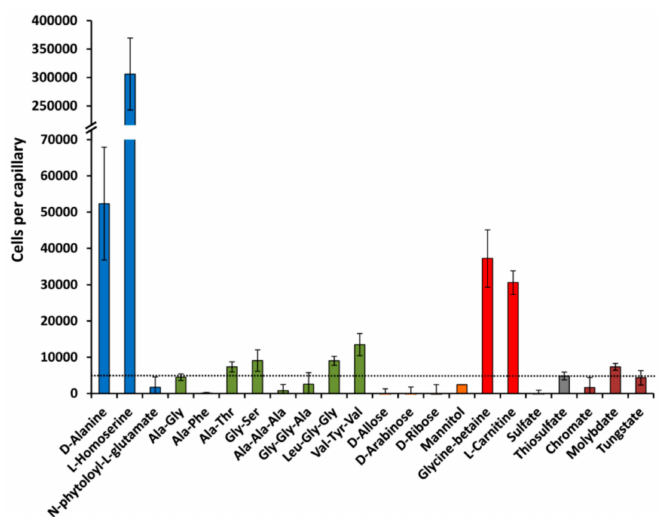
Figure 10. Chemotaxis of Pseudomonas aeruginosa PAO1 towards di ff erent ligands recognized by solute binding proteins. In all cases, the chemoe ff ector concentration was 1 mM, except molybdate which was at 0.1 mM. Data are means and standard deviations from three biological replicates conducted in triplicate. Data were corrected with the number of cells that swam into bu ff er containing